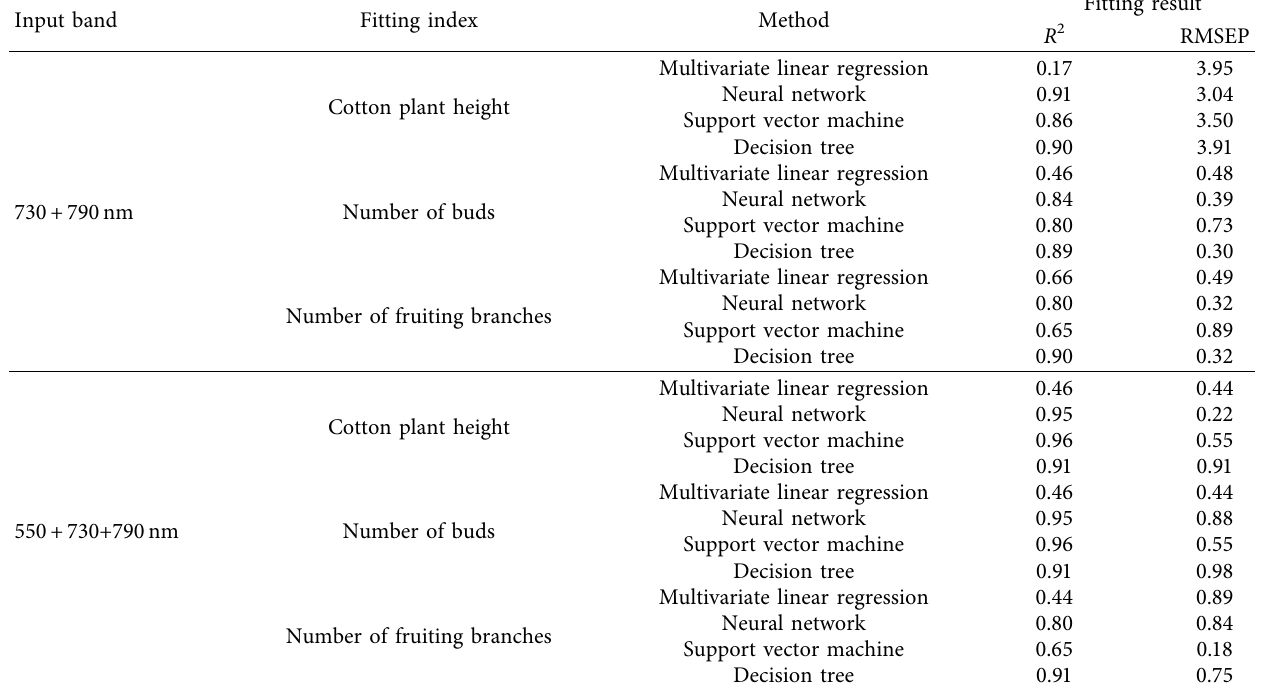
Table 3: The regression table of the combinations band and the cotton of plant height, buds, and fruiting branches. Input